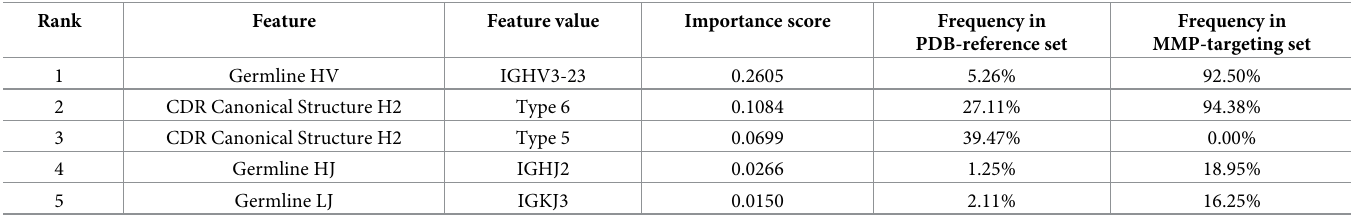
Table 4. Top 5 salient feature values as determined by feature selection.